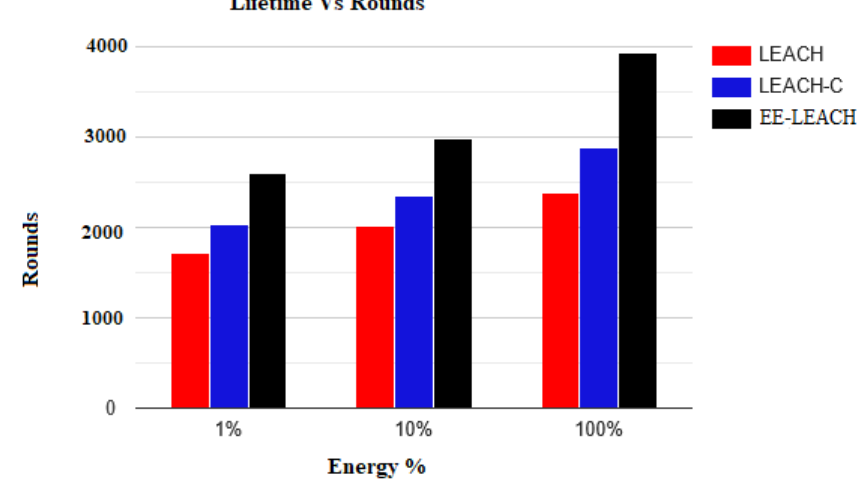
Figure 8. Lifetime vs. rounds.